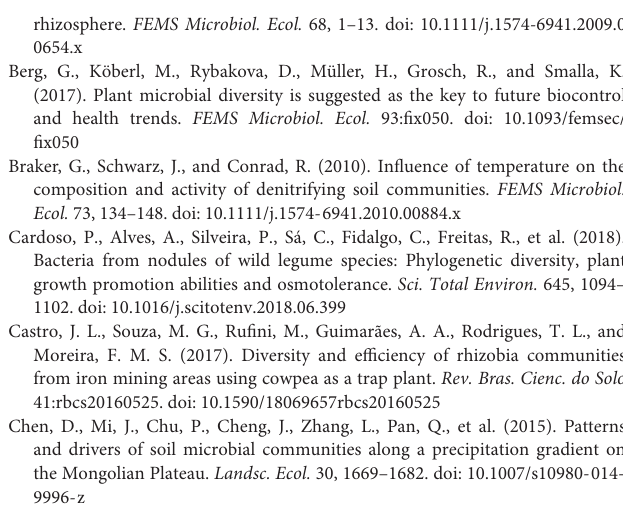
Supplementary Figure 1 | Diagram of adapted Leonard jars with the three layers: substrate mixture (gravel and vermiculite), soil sample and sand. Supplementary Table 1 | Illumina MiSeq sequence raw data from Mothur